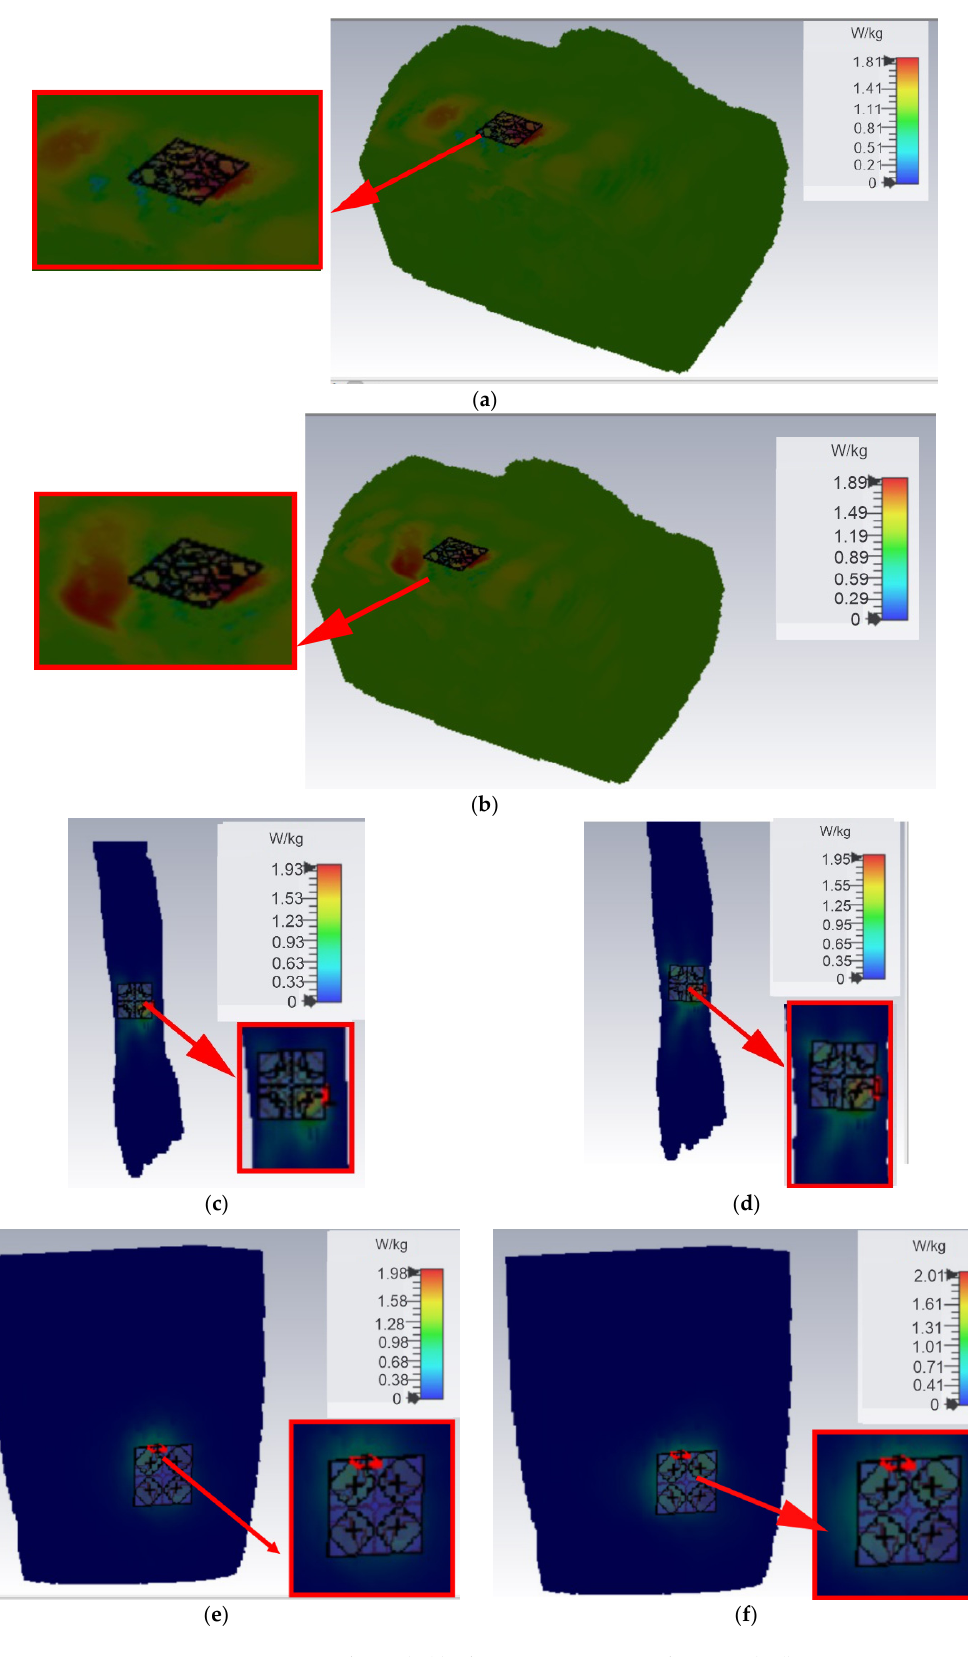
Figure 12. SAR analysis: ( a , b ) ribcage at 3.5 GHz and 5 GHz; ( c , d ) arm at 3.5 GHz and 5 GHz; ( e , f ) leg at 3.5 GHz and 5 GHz.